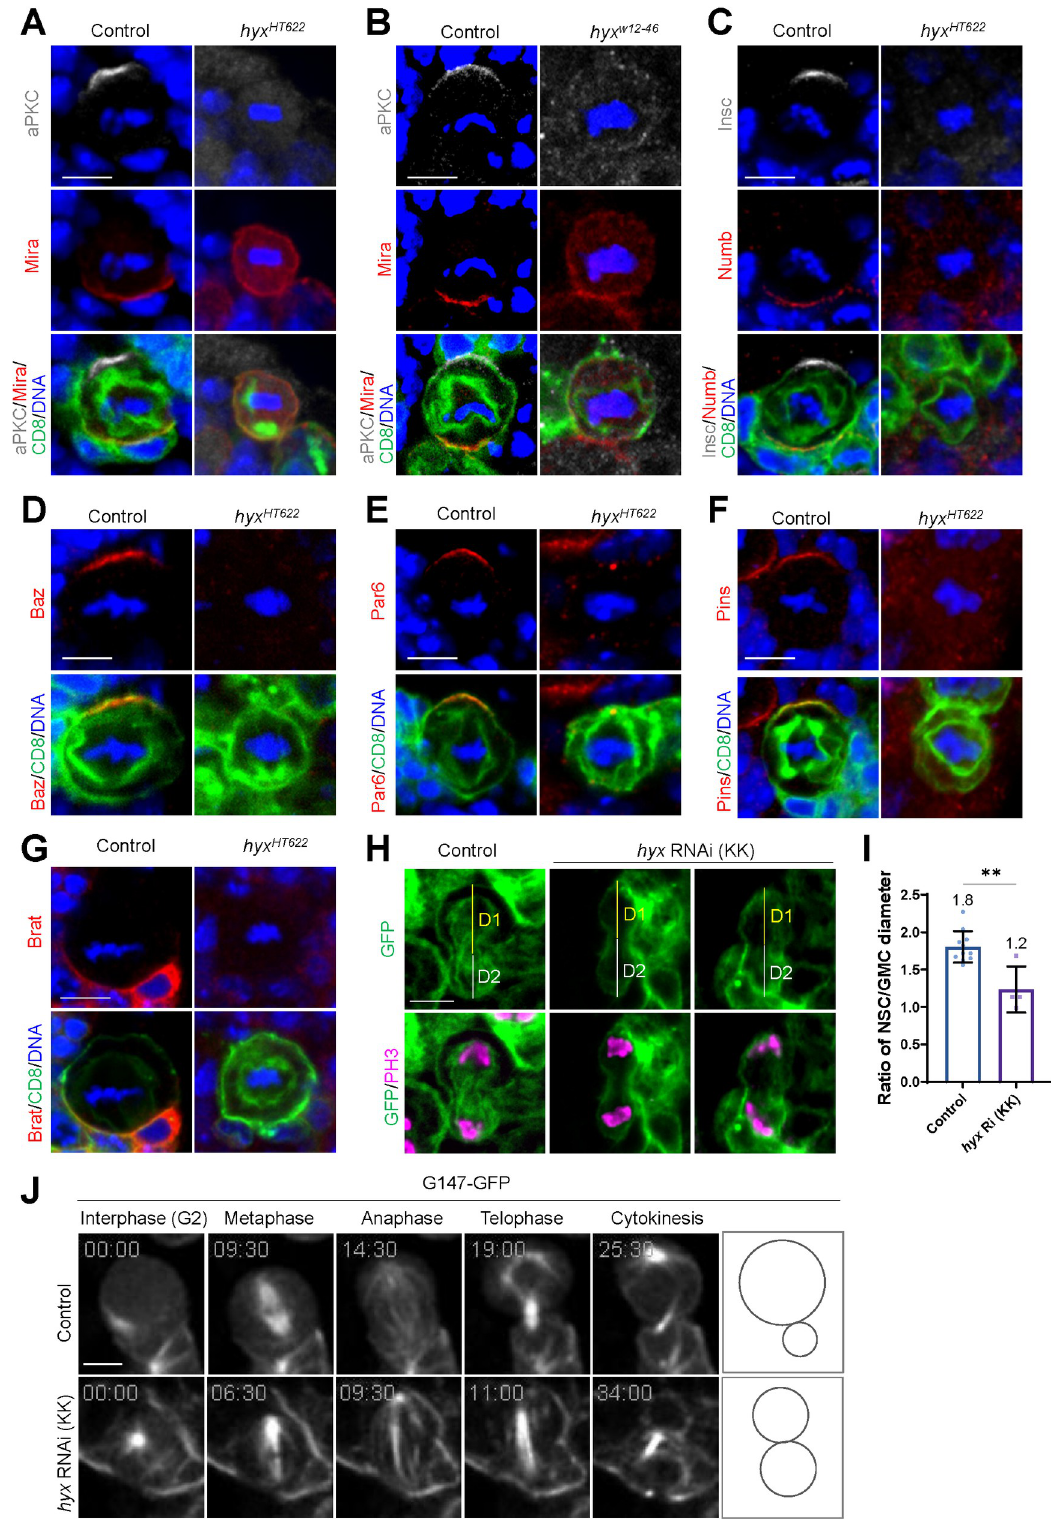
Fig 2. Hyx is essential for asymmetric cell division of NSCs. ( A ) Metaphase NSCs of control (FRT82B; n = 50) and hyx HT622 MARCM clones were labeled for aPKC, Mira, and DNA. hyx HT622 , aPKC delocalization, 100%; Mira delocalization, 81.6%; n =